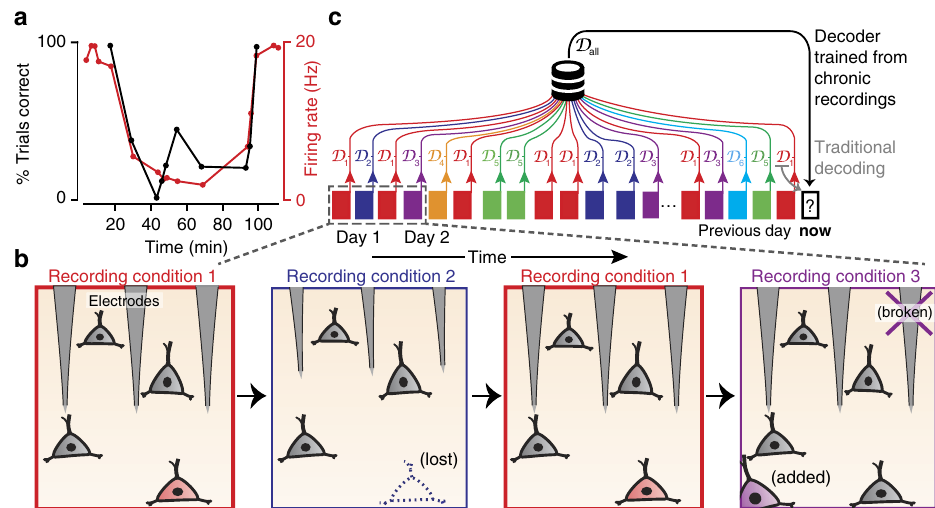
Figure 1 | Strategy for training a decoder robust to recording condition changes. ( a ) Example data from a BMI clinical trial showing sudden decoder failure caused by a recording condition change. The black trace shows the participant’s closed-loop performance over the course of an experiment using a fixed Kalman filter. An abrupt drop in performance coincides with a reduction in the observed firing rate (red trace) of a neuron with a high decoder weight. Both the neuron’s firing rate and decoder performance spontaneously recover B 40min later. Adapted from Figure 7 of ref. 13. ( b ) A cartoon depicting one hypothetical cause of the aforementioned change: micro-motion of the electrodes leads to Recording Condition 2, in which spikes from the red-shaded neuron are lost. BMI recovery corresponds to a shift back to Condition 1. Over time, further changes will result in additional recording conditions; for example, Condition 3 is shown caused by a disconnected electrode and an additional neuron entering recording range. ( c ) Recording conditions (schematized by the coloured rectangles) will vary over the course of chronic intracortical BMI use. We hypothesize that oftentimes new conditions are similar to ones previously encountered (repeated colours). Typically, decoders are fit from short blocks of training data and are only effective under that recording condition (decoders D 1 , D 2 , y ). Consider the goal of training a decoder for use at time ‘now’ (black rectangle on right). Standard practice is to use decoder D 1 trained from the most recently available data (for example, from the previous day or the start of the current experiment). D 1 will perform poorly if the recording condition encountered differs from its training data. To increase the likelihood of having a decoder that will perform well given the current recording condition, we tested a new class of decoder, D all , trained using a large collection of previous recording